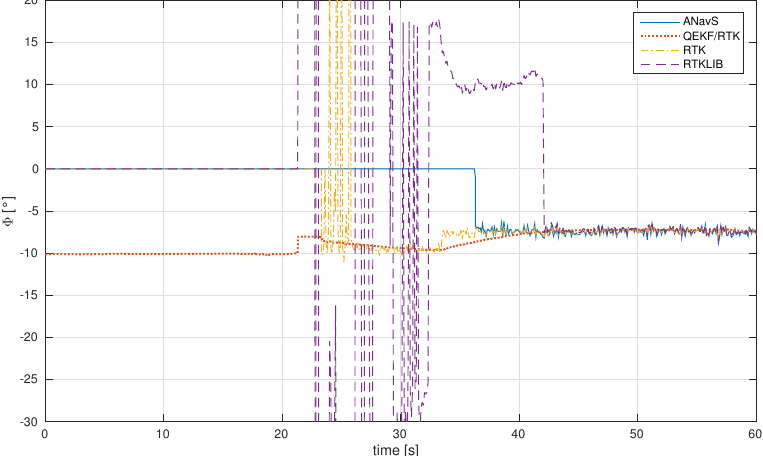
Figure 5. Time to first fix: the reference system from ANavS, the proposed method and its GPS heading measurements and the GPS heading acquired from the RTKLIB using its standard settings for a moving baseline.